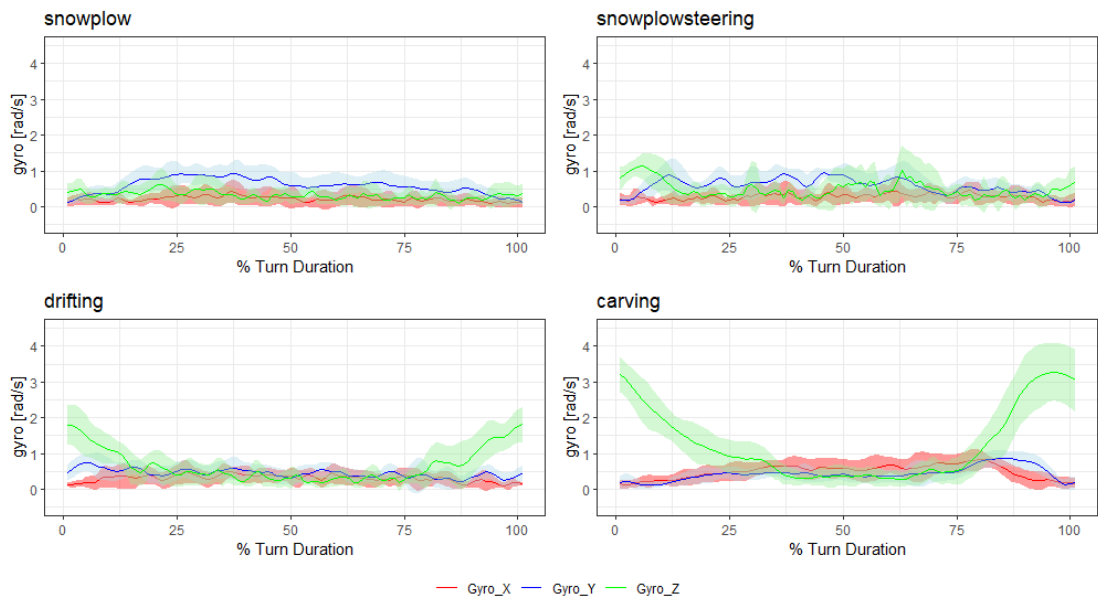
Figure 3. Gyroscope data for each style.